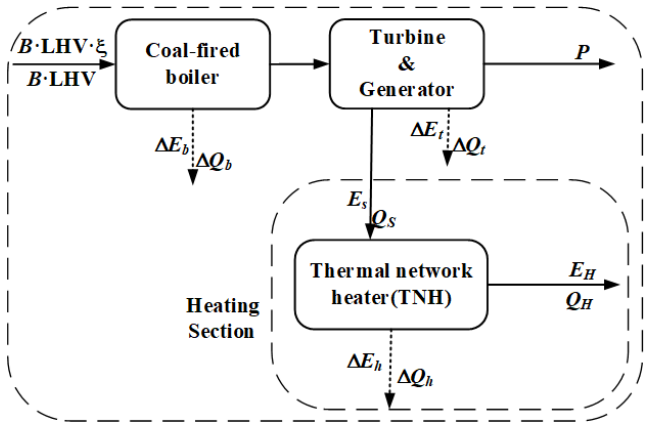
Figure 9. Diagram of energy and exergy flows of the CHP